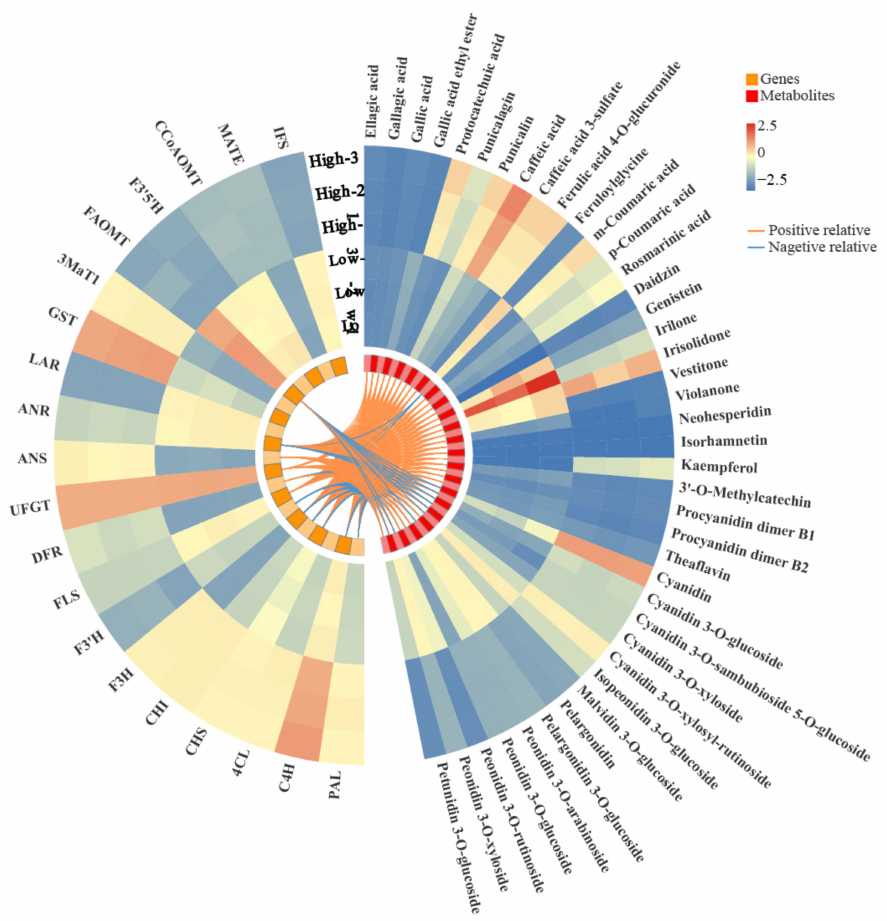
Figure 11. Correlation network of representative genes ( left ) and polyphenol ingredients ( right ) in response to the salinity